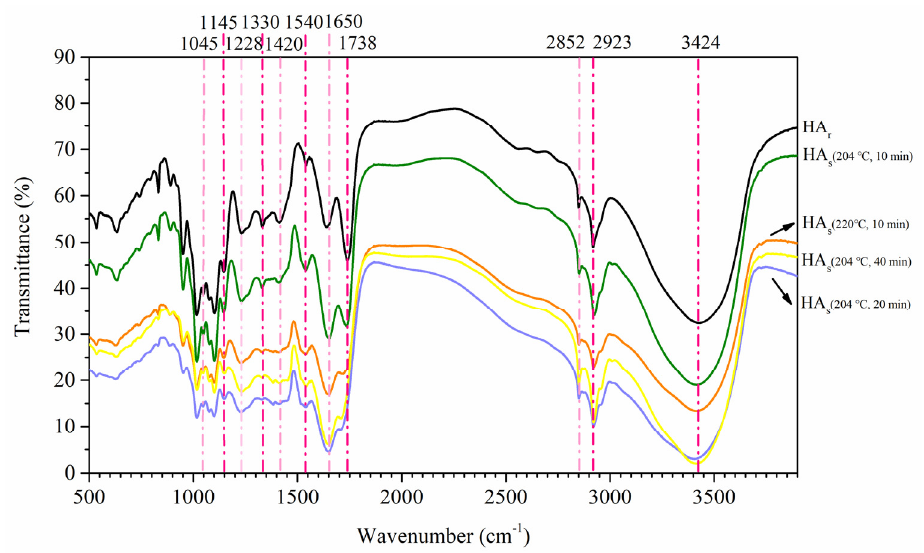
Figure 3. FTIR spectra of HA isolated from raw broccoli and SE broccoli.